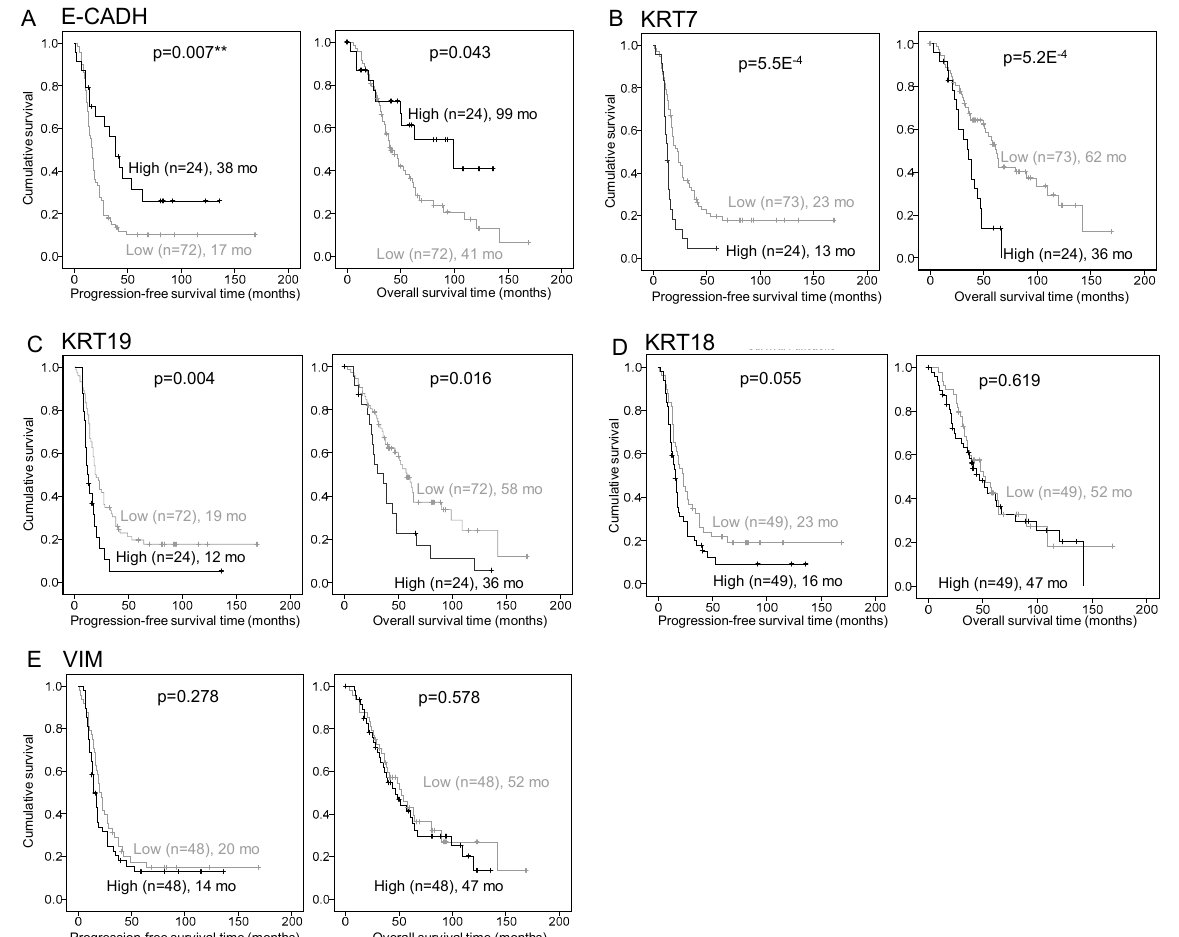
Figure 2. KRT7, KRT19, and E-CADH expression associate with prognosis in the HGSC Discovery cohort ( n = 101). ( A – E ) Kaplan–Meier curves of E-CADH ( A ), KRT7 ( B ), KRT18 ( C ), KRT19 ( D ), and VIM ( E ) expression associations with progression-free survival (left) and overall survival (right). MFI measured expression of markers was dichotomized by the median for KRT18 and VIM and by the 75th percentile for E-CADH, KRT7, and KRT19, into groups of low and high expression. p values are indicated, ** = p < 0.01. Number of patients and estimated median survival months (mo) are indicated for each group.